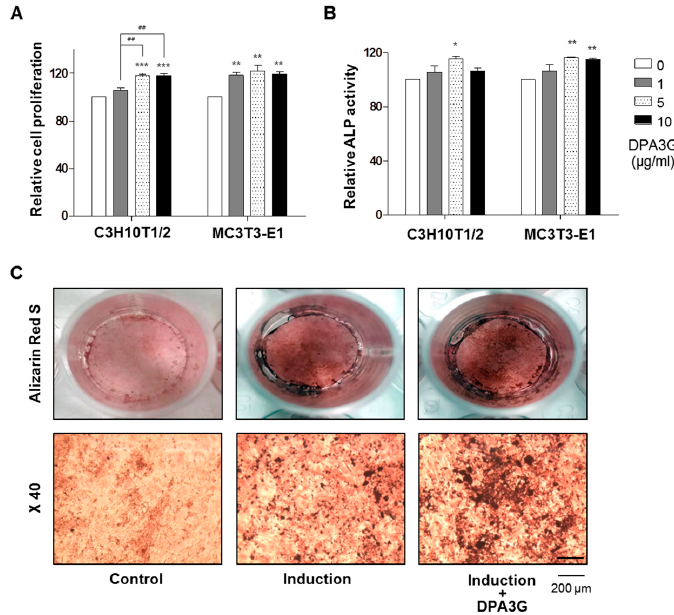
Figure 2. Effects of (1 ′ R ,2 ′ S ,5 ′ R ,8 ′ S ,2 ′ Z ,4 ′ E )-dihydrophaseic acid 3 ′ - O - β - D -glucopyranoside (DPA3G) on cellular proliferation, differentiation, and mineralized nodule formation of the osteoblast-lineage cell lines. ( A ) Assessment of the cellular proliferation in the DPA3G fraction–treated